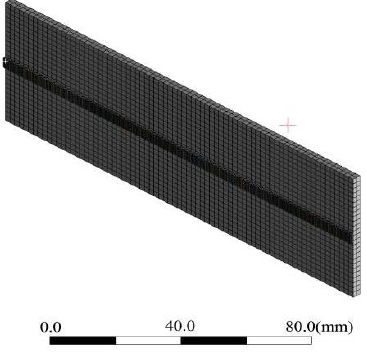
Figure 1. The 3D model.